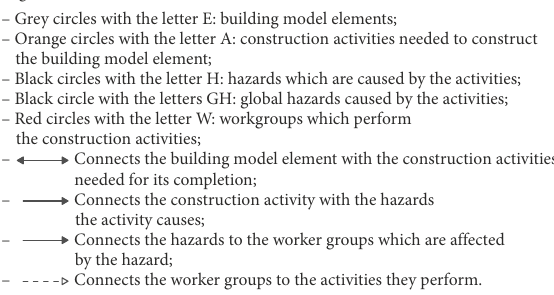
Figure 6. Element-Activity-Hazard-Worker interaction model